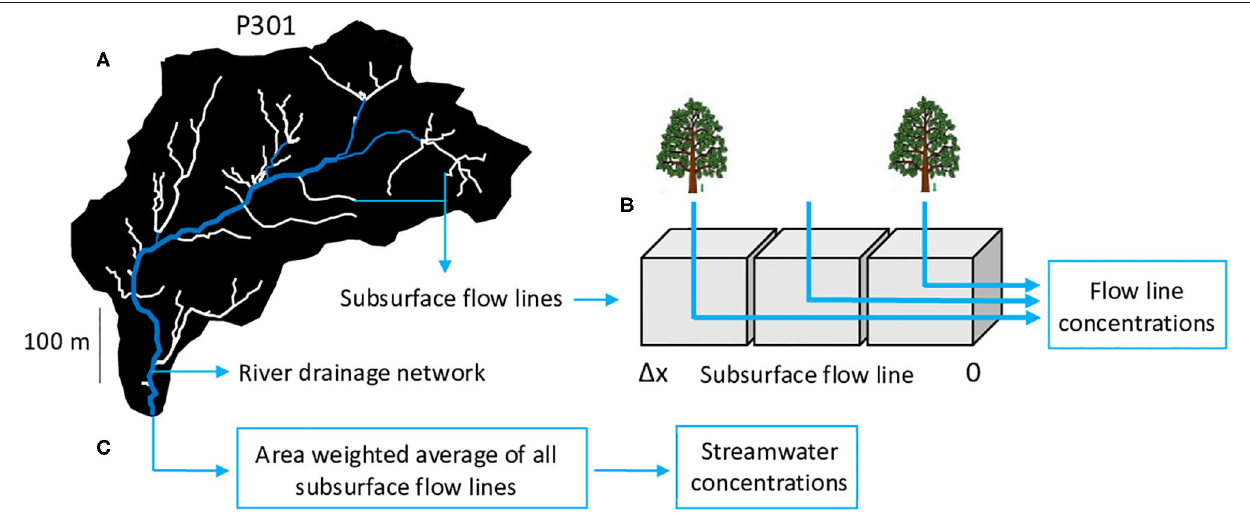
FIGURE 2 | Conceptual scheme used in modeling ionic concentrations in streamwater for all watersheds. (A) River network (in blue) and subsurface flow lines (in white) are determined by geomorphologic analysis using a 1-m DEM. The river network collects water coming from the subsurface flow lines, and the water chemical composition is assumed unchanged during the fast transfer in the streams. (B) Reactive-transport modeling along the 1D subsurface flow lines in the watersheds. The regolith is horizontally discretized into a 1D succession of cells along the subsurface flow lines. Within each cell, the geochemical and transport equations are numerically solved using the KIRMAT hydrogeochemical code. Subsurface flow lines are assumed to deliver subsurface water to the stream once reaching the river network. 1 x to 0 is the distance from stream along the subsurface flow lines. A single layer with depth-averaged regolith properties is used along the vertical direction. (C) Final streamwater concentrations are calculated by taking the average chemical compositions across all subsurface flow lines. This average is weighed by the drainage area of each subsurface flow line to consider that long flow lines carry more water than shorter ones.